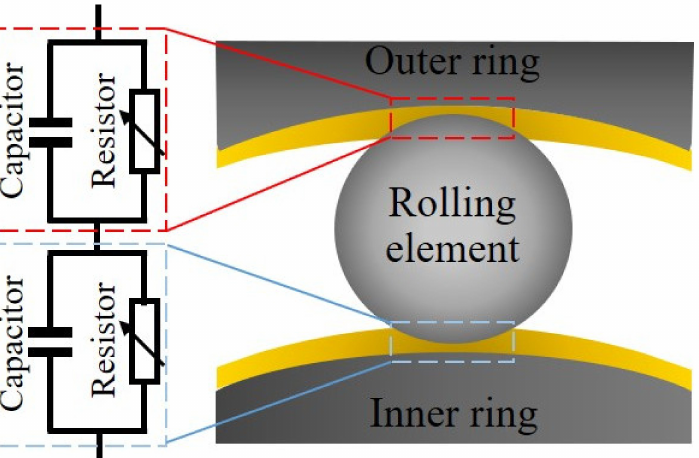
Figure 1. An illustration of simplified electrical circuits of race-rolling element-race contacts in a rolling element bearing lubricated by a dielectric